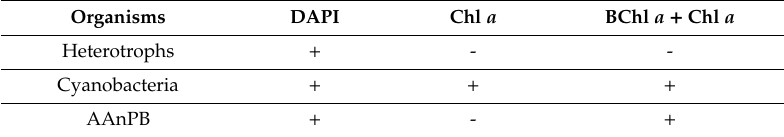
Table 1. Scheme for the identification of AAnPB in epifluorescence microscope imaging.